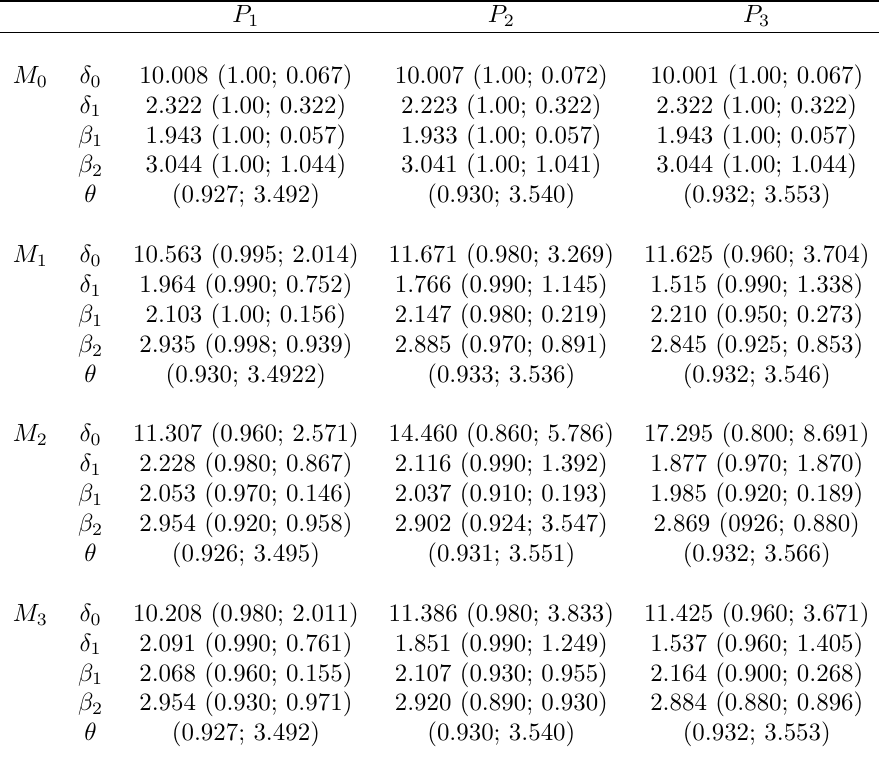
Invariant PRAM: posterior mean by misclassification probability P for different models. In parentheses ACP and RMSE, respectively. In the last line, we show the average ACP and RMSE of the small area